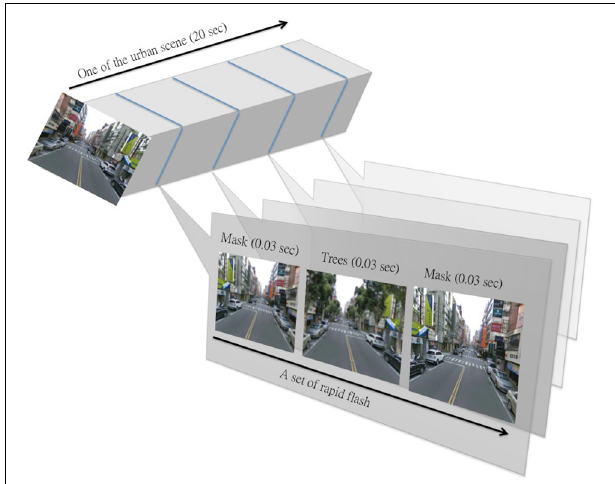
FIGURE 2 | How the rapid flashed of street trees were flashed in. (Note: A mask is the horizontally flipped image of the streetscape being